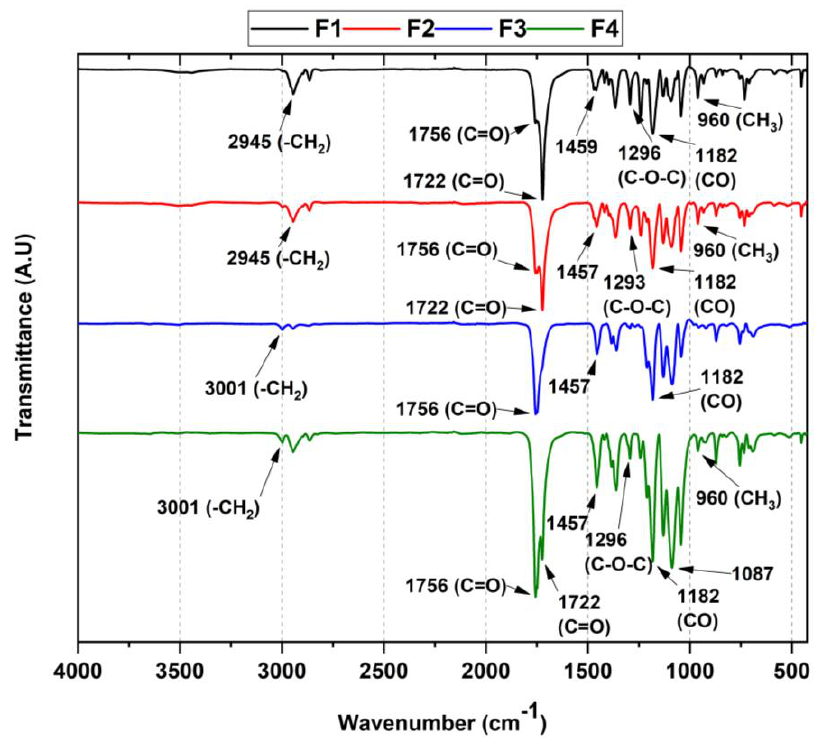
Figure 2. FT-IR of the four membranes (F1–F4 according to Table 1). F1, 30% PCL/70% PLA; F2, 27% PCL/70% PLA/3% TiO 2 ; F3, 20% PCL:70% PLA:10% OEO; F4, 17% PCL:70% PLA:3% TiO 2 :10% OEO.